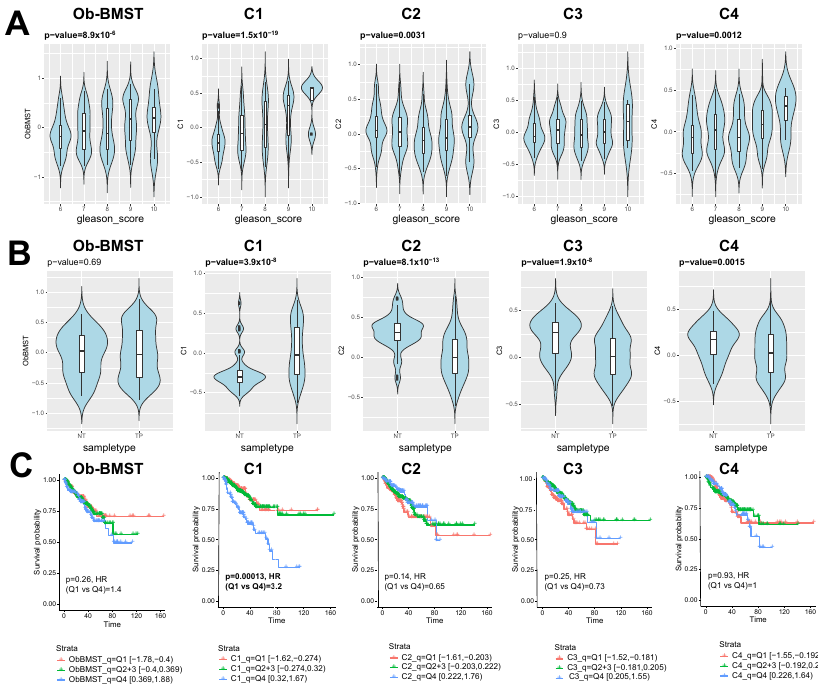
Figure 9. Stroma signatures identified from bone metastatic PDXs as prognostic biomarkers in primary PCa. ( A ) Violin plots showing Gene Set Variation Analysis (GSVA) signature scores of the Ob-BMST, C1-C4 gene sets, stratified by Gleason score from the TCGA cohort. Box-and-whisker plots illustrating median (midline), inter-quartile range (box), with the whiskers extending to at most 1.5 IQR from the box. Outliers beyond the range of the whiskers are illustrated as dots. P-values computed by Spearman correlation tests. ( B ) Violin plots showing GSVA signature scores of the Ob-BMST and C1-C4 gene sets stratified by sample types (NT: nontumor and TP: primary tumor) from the TCGA cohort. Box-and-whisker plots illustrating the median (midline) and interquartile range (box), with the whiskers extending to at most 1.5 IQR from the box. Outliers beyond the range of the whiskers are illustrated as dots. P -values computed by Mann-Whiney U tests. ( C ) Kaplan-Meier plots of progression-free survival (PFS) stratified as the bottom 25% (Q1), middle 50% (Q2 and 3) and top 25% (Q4) of the signature scores of the Ob-BMST and C1-C4 gene sets. P -values and hazard ratios computed by Cox proportional hazard